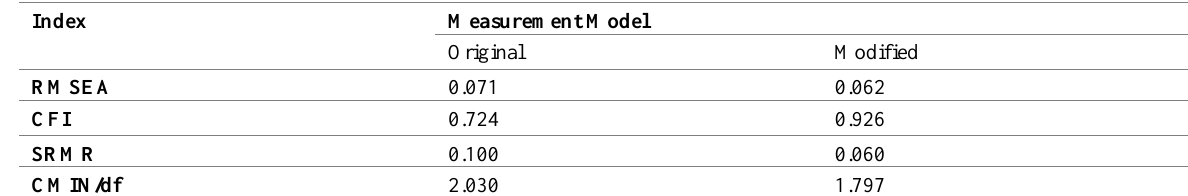
Table 4: Model fit indices for original and modified measurement